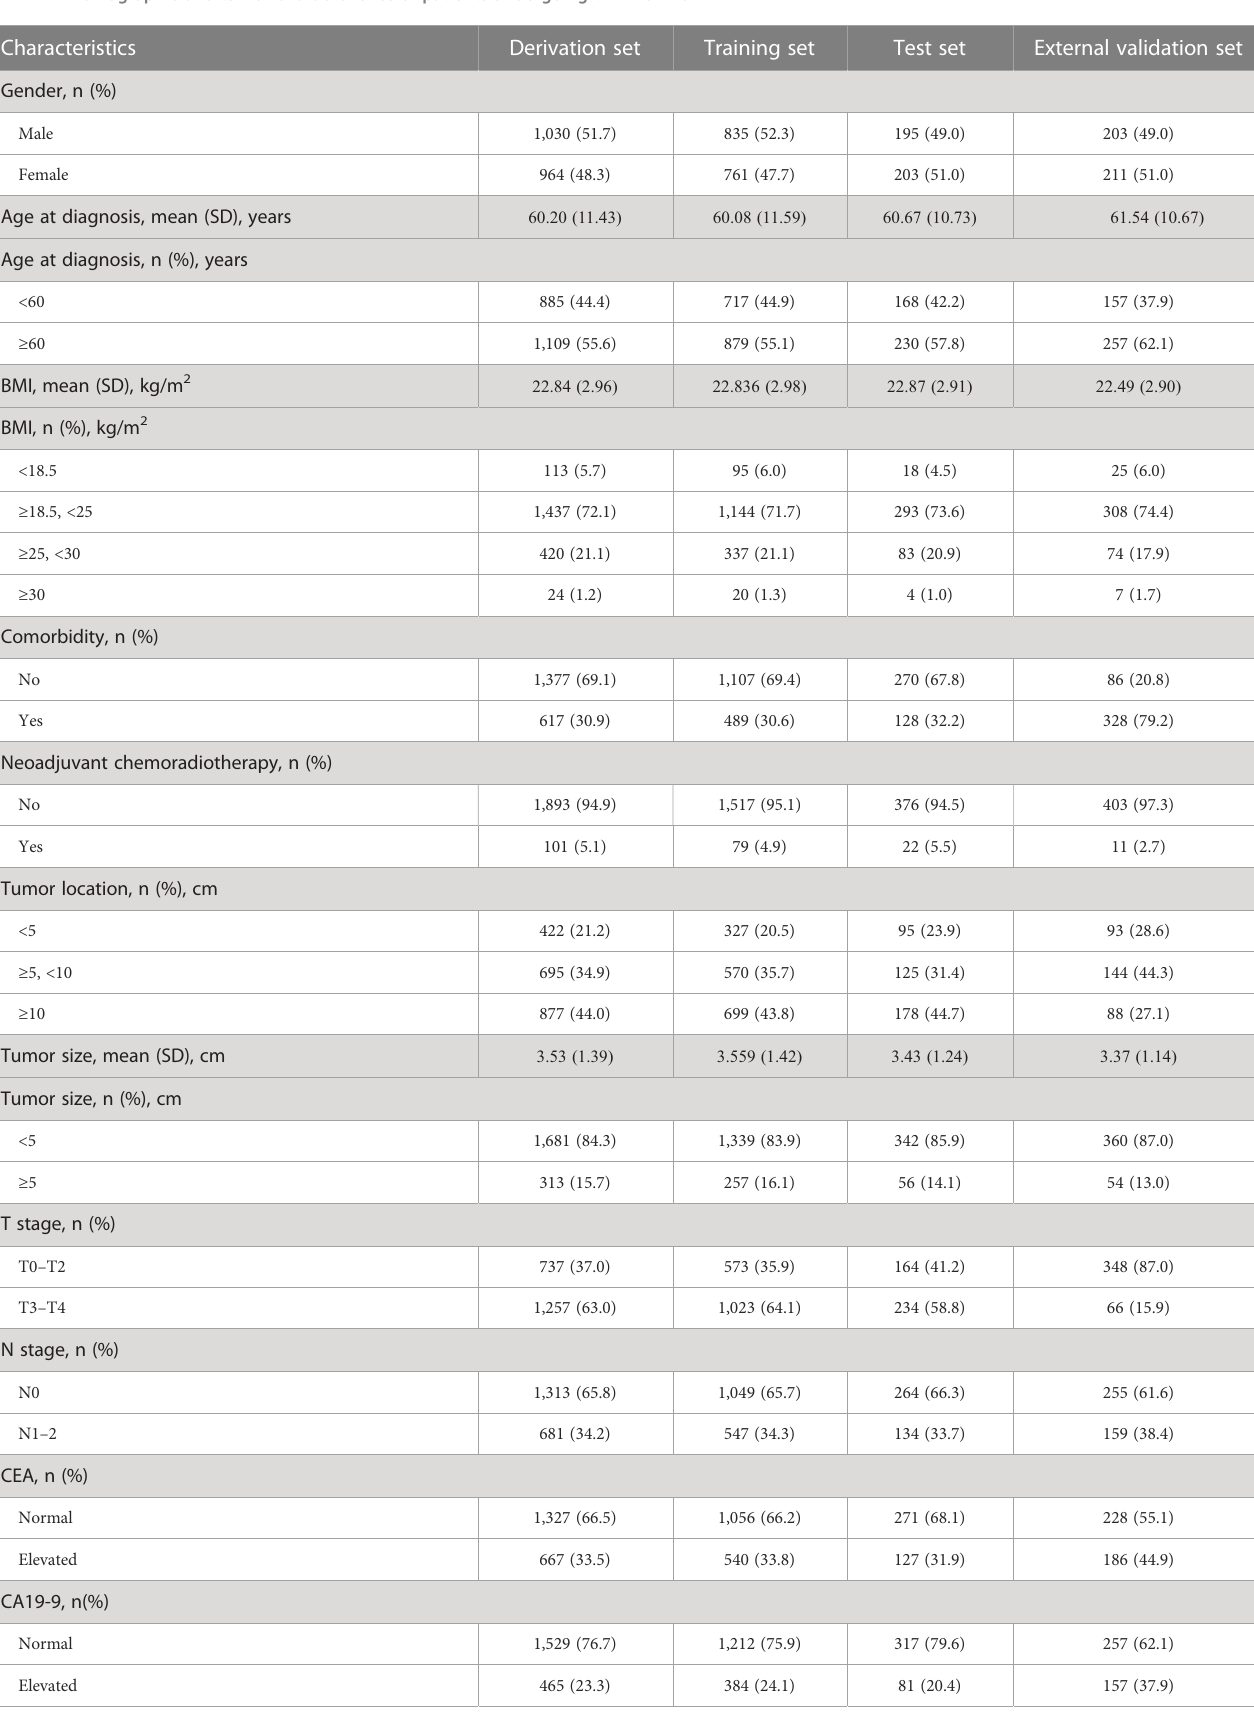
TABLE 1 Demographic and tumor characteristics of patients undergoing tLAR for RC.